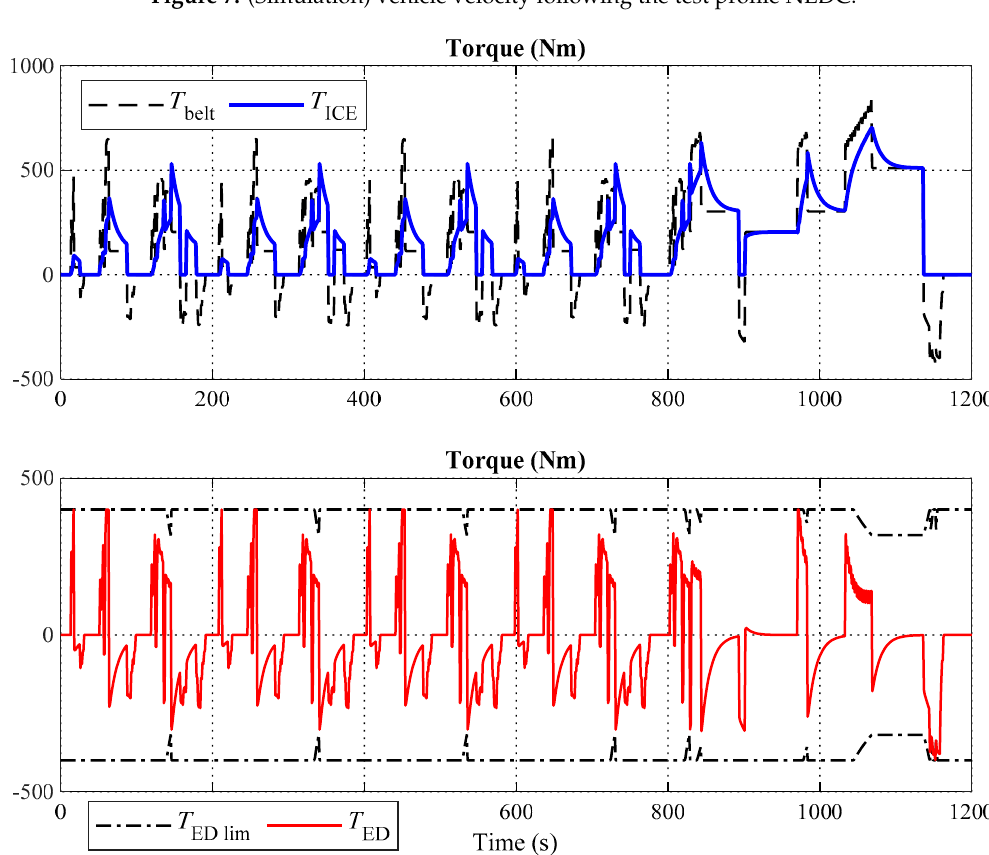
Figure 8. (Simulation) torque distribution results of belt, ICE, and ED torques with NEDC.